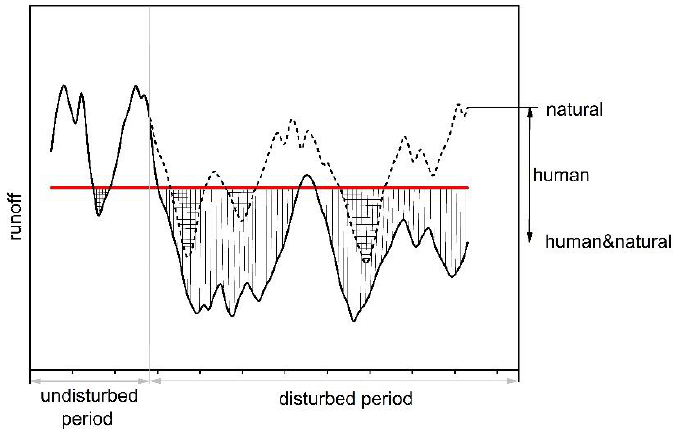
Figure 2. Conceptual diagram of a system affected by natural factors and human factors.